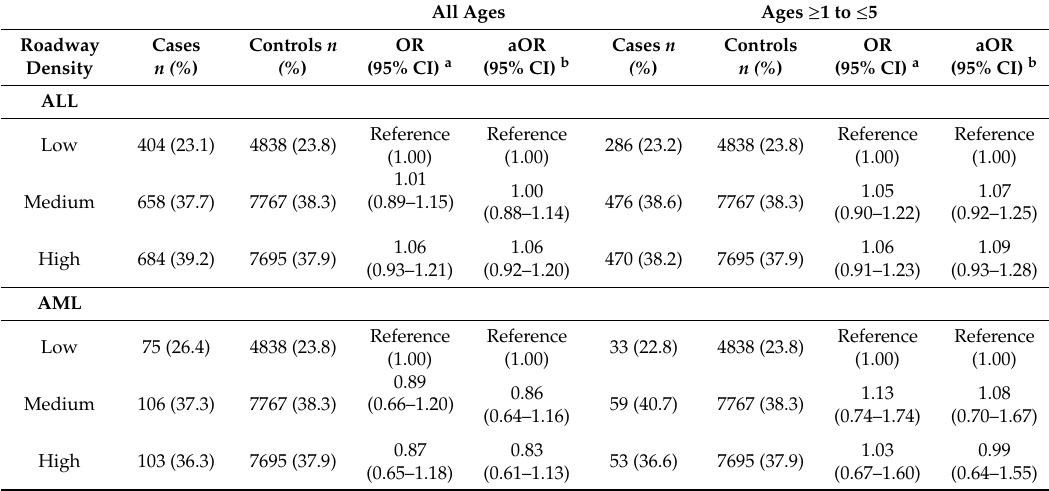
Table 4. Associations between maternal residential roadway density and leukemia in o ff spring. All Ages Ages ≥ 1 to ≤